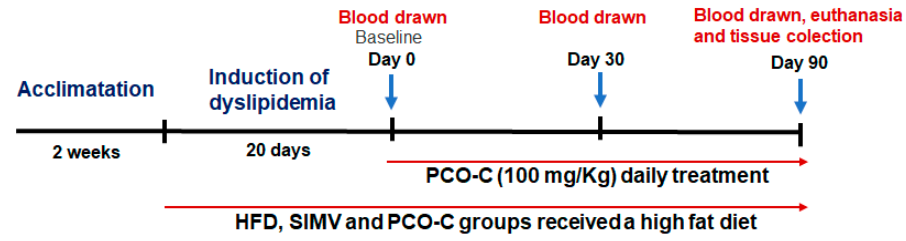
Figure 1. Outline diagram of the in vivo experimental study.